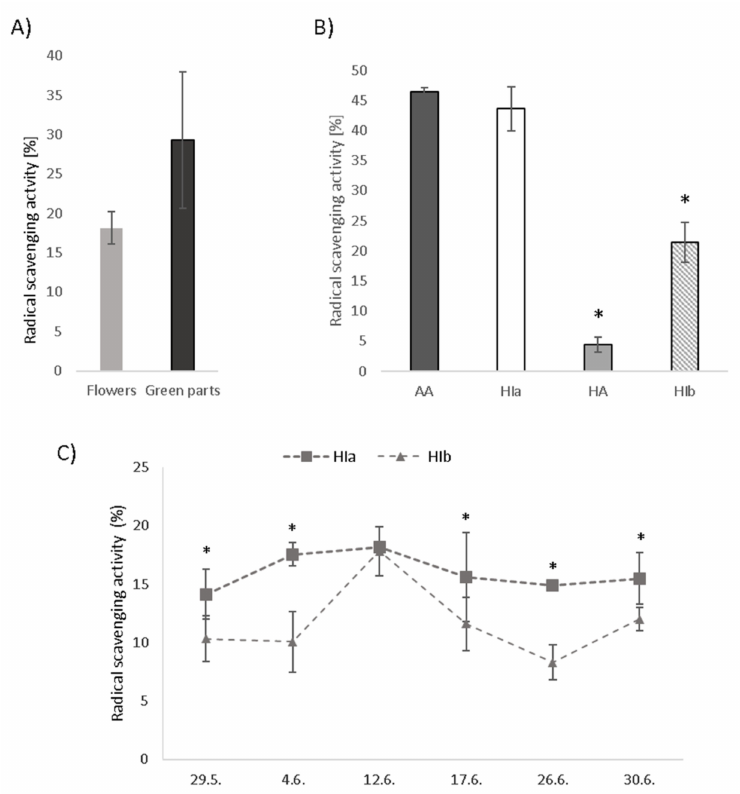
Figure 2. Radical scavenging activity measured by the DPPH test in ( A ) infusions prepared from flowers and green parts of HIa, ( B ) HIa, HIb, and HA infusions in comparison to 25 µ M ascorbic acid (AA) and ( C ) HIa and HIb collected on different dates, all at a 12.5% v / v concentration. Mean ± SD is presented; * p <